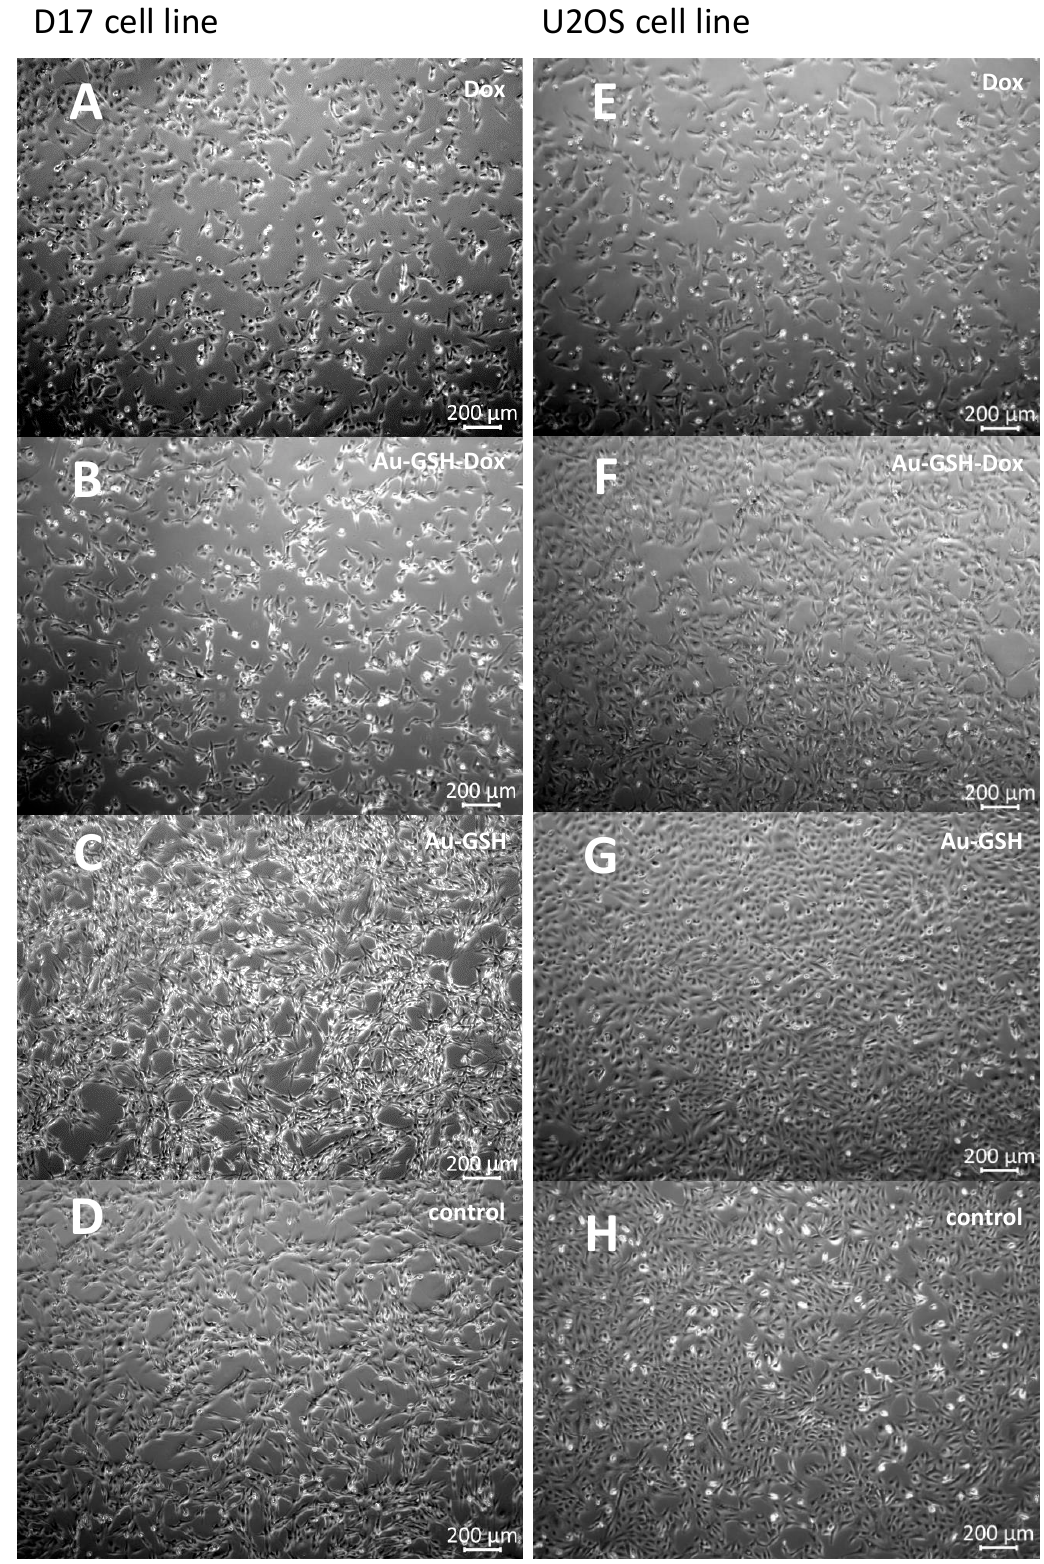
Figure 5. Phase-contrast microscopy images of D17 and U2OS OSA cells treated with 5 μ g/mL of Dox ( A , E ), 5 μ g/mL of Au-GSH-Dox ( B , F ), 100 μ g/mL of Au-GSH (as the Dox/Au-GSH concentration ratio in Au-GSH-Dox was 1:20) ( C , G ), and untreated (negative control) ( D , H ). 4× magnification, scale bar 200 μ m .